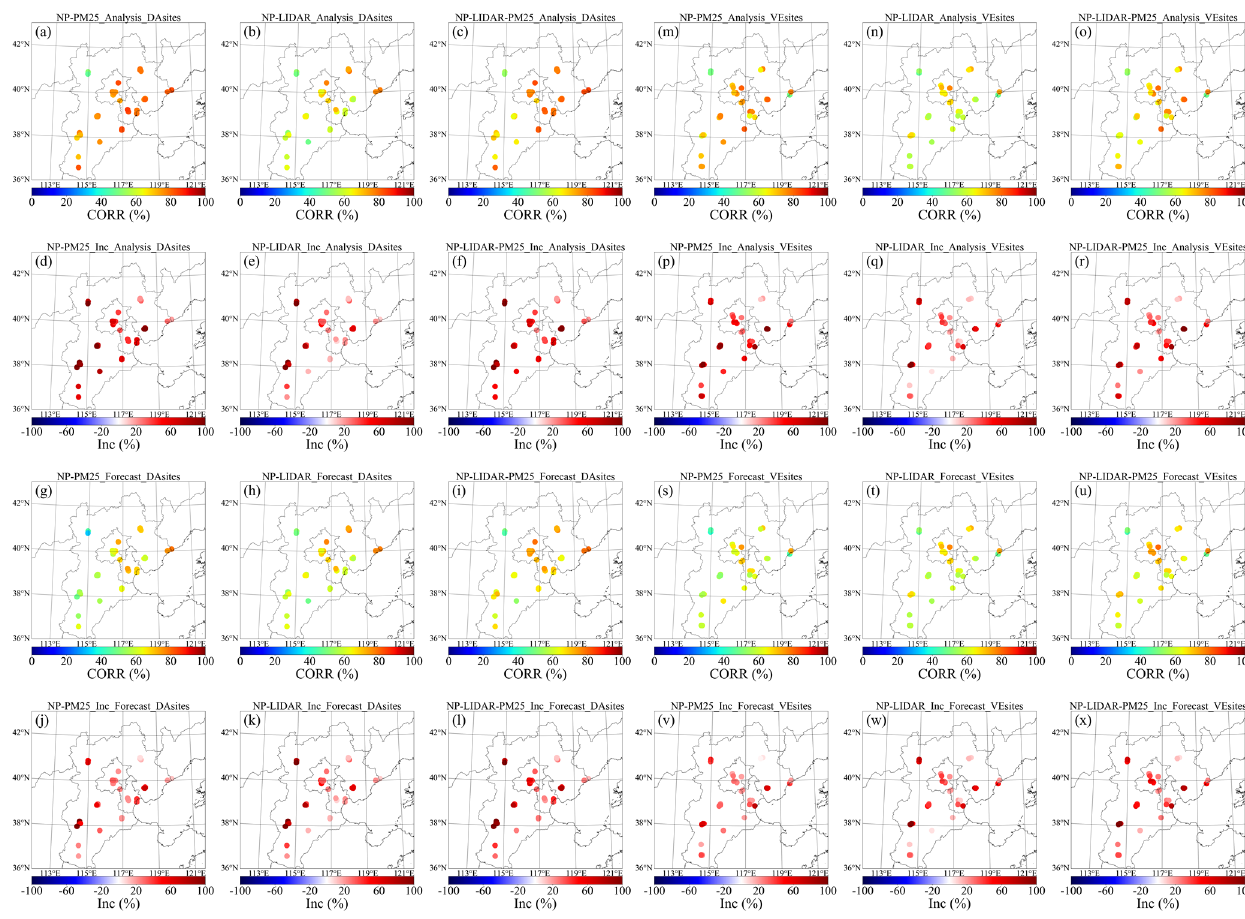
Figure 11. Same as Fig. 10 but with CORR.